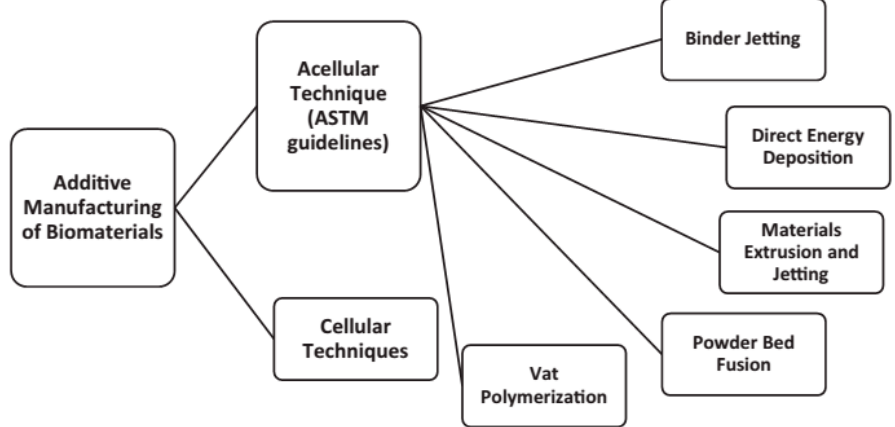
Figure 11. Acellular techniques for the additive manufacturing (AM) of biomaterials [64].